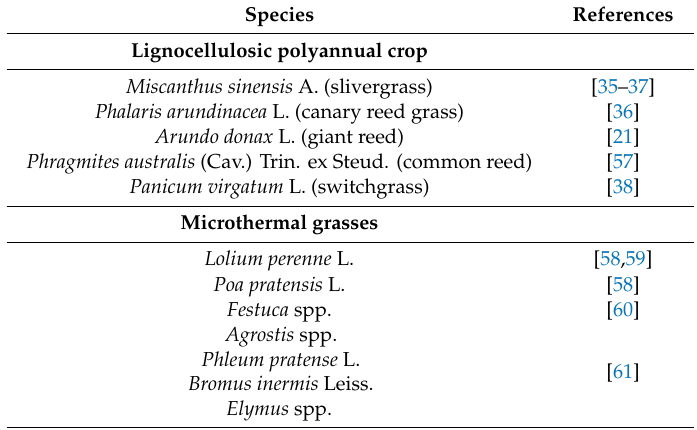
Table 2. Grasses and herbaceous lignocellulosic crops for